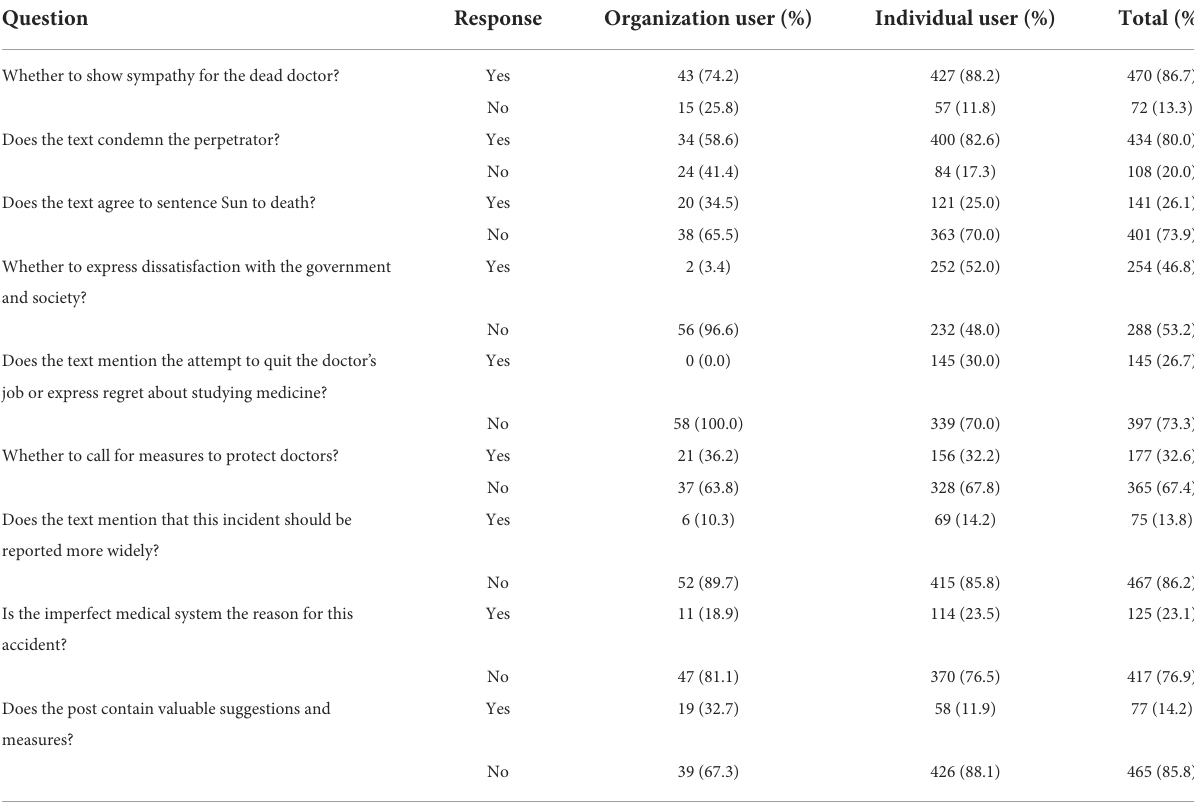
TABLE 1 Views of individual Weibo users and organization Weibo